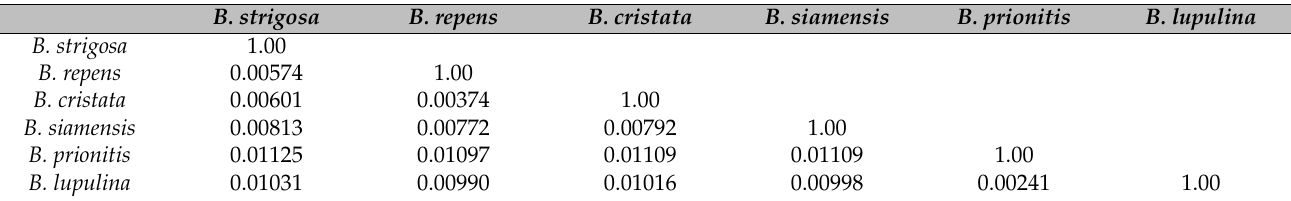
Table 4. Genetic distance analysis of the Barleria chloroplast genome.